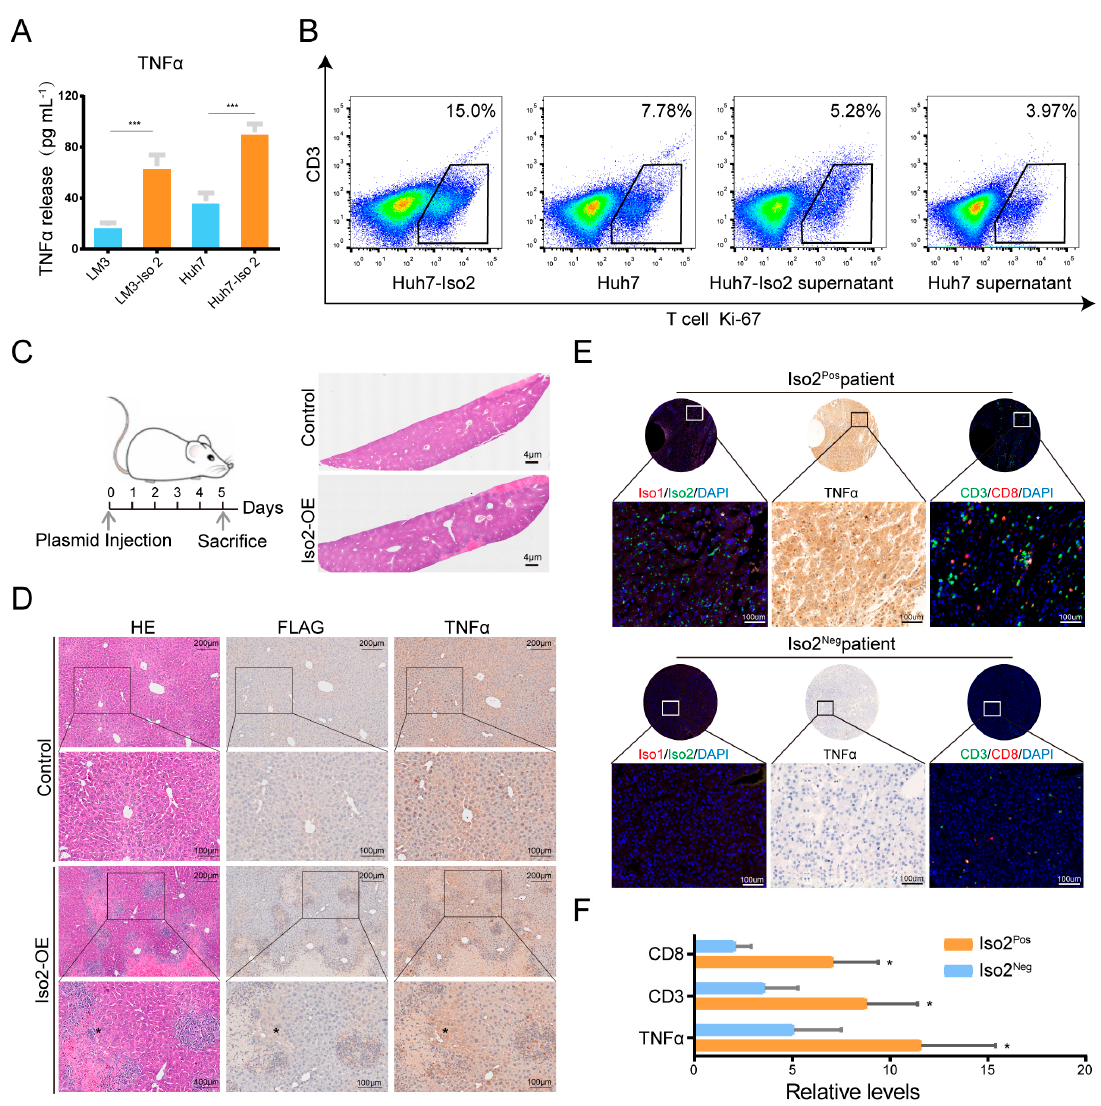
Figure 7. The regulation of Iso2 on TNF- α expression and T cell numbers veri fi ed by in vitro and in vivo experiments. ( A ) Increased TNF- α in protein level induced by the overexpression of Iso2. ( B ) Ki-67 staining of T cells with the indictment. ( C , D ) The extent of damage, in fl ammatory in fi ltration and the elevation of TNF- α triggered by slightly overexpressed Iso2 in normal liver using the mouse model of hydrodynamic tail-vein injection. The representative data were determined by HE staining and IHC staining. ( E , F ) The co-expression and co-localization pa tt erns of Iso2, TNF- α and CD3 + /CD8 + T cells in a liver cancer tissue microarray. Data were presented as mean ± SD, * p < 0.05, *** p < 0.001.